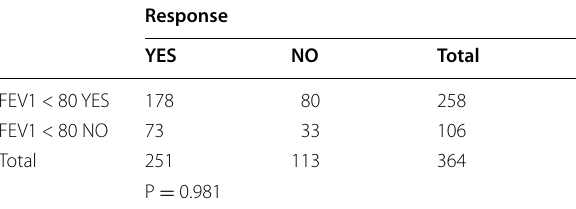
Table 3 Response vs FEV1 < 80